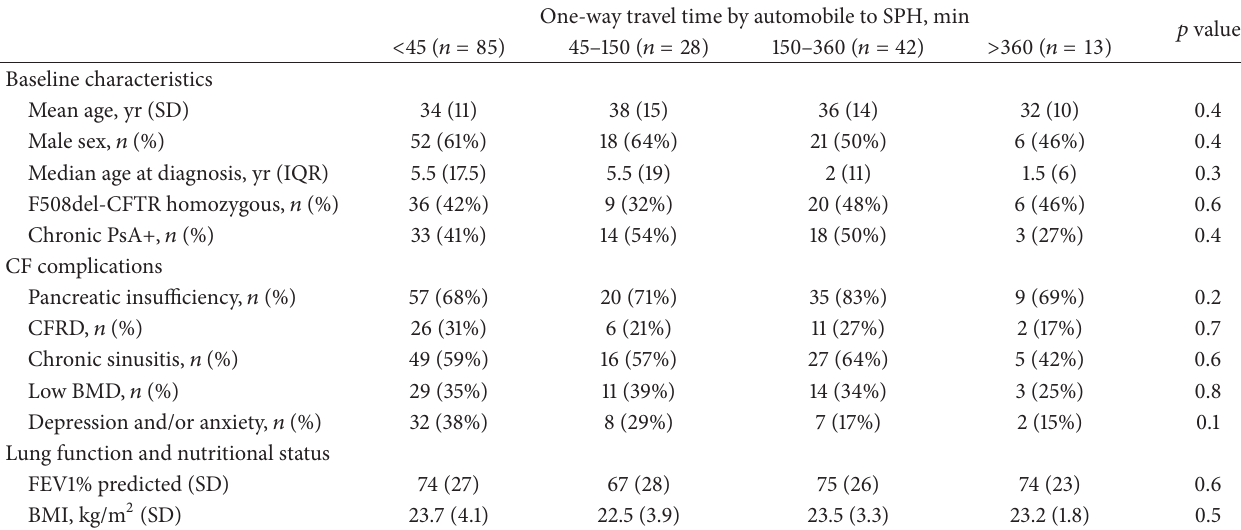
Table 1: Baseline characteristics, CF complications, lung function, and nutritional status by travel time. One-way travel time by automobile to SPH,